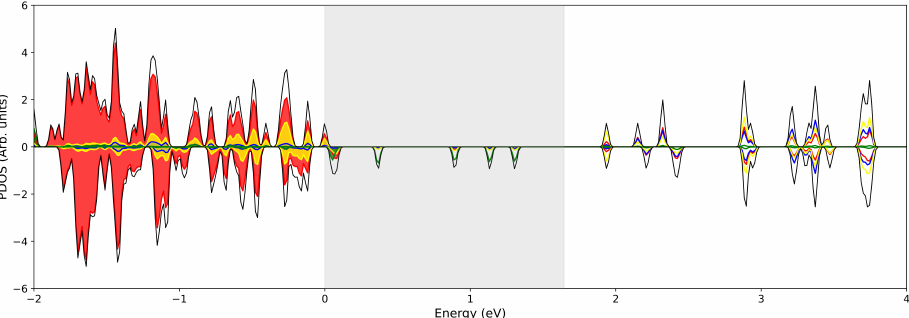
Figure A5. PDOS of CuAlS 2 containing an isolated [ Fe Cu ] 2 + antisite defect (copper = red, sulfur = yel- low, aluminium = blue and iron =